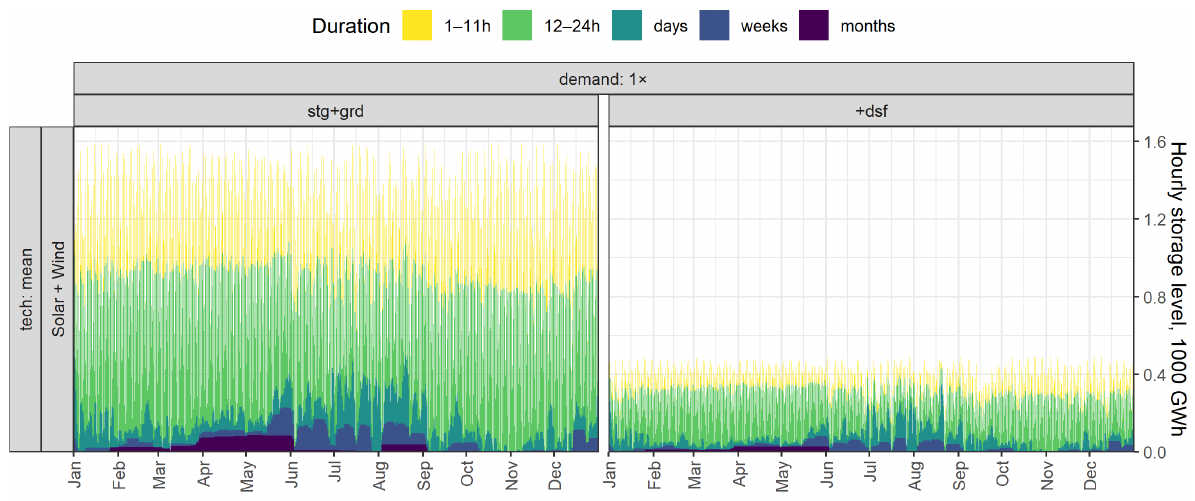
Figure 11. Decomposition of storage level by duration of the charge in scenarios with and without demand